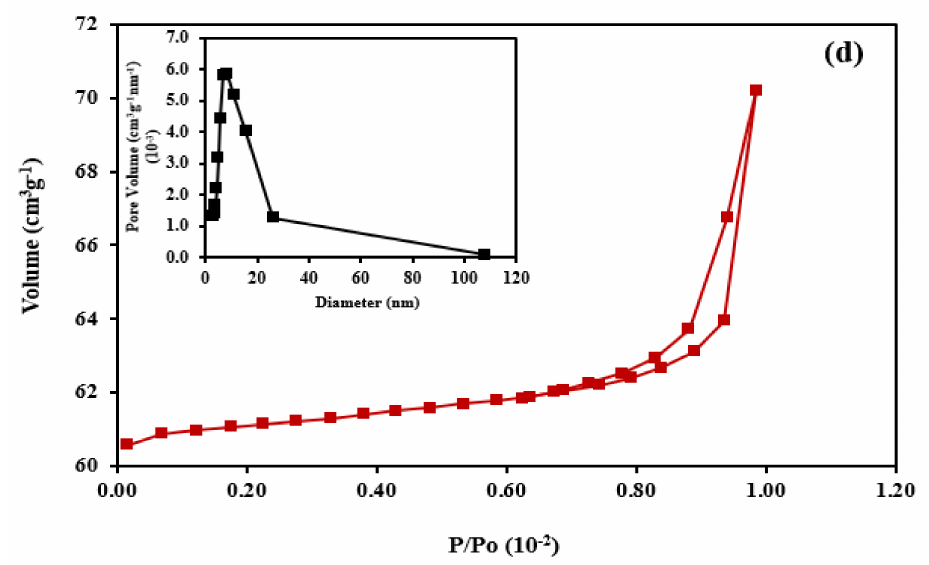
Figure 4. Adsorption—desorption N 2 graphs and corresponding pore size distribution (inset) of